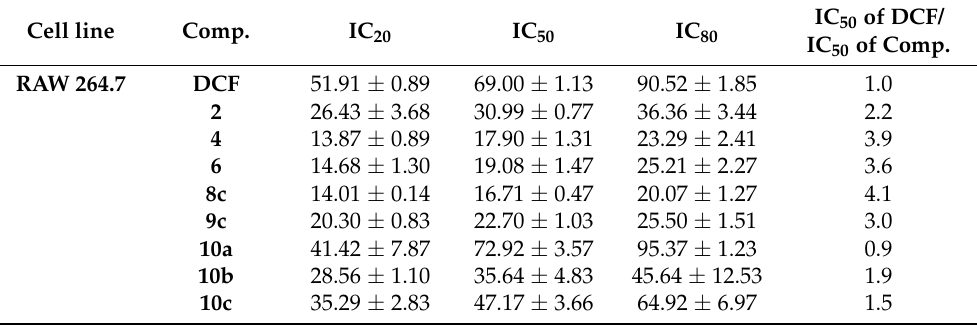
Table 2. Growth-inhibitory effects as IC 20 , IC 50 , and IC 80 ( µ g · mL − 1 ) values of compounds 2 , 4 , 6 , 8c , 9c , 10a-c, and DCF against RAW 264.7 monocyte/macrophage murine cells. The last column represents the ratio between IC 50 of DCF and the IC 50 of the